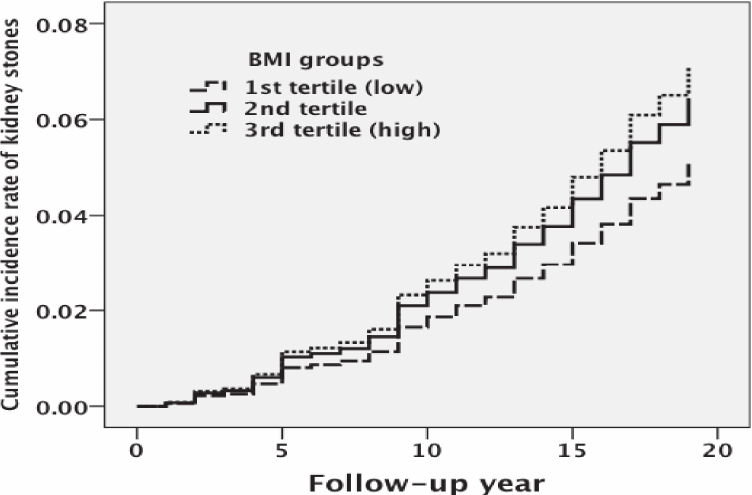
Figure. Relationship between the incidence rate of kidney stones and body mass index (BMI). The high BMI group had a higher cumulative incidence rate of kidney stones than other